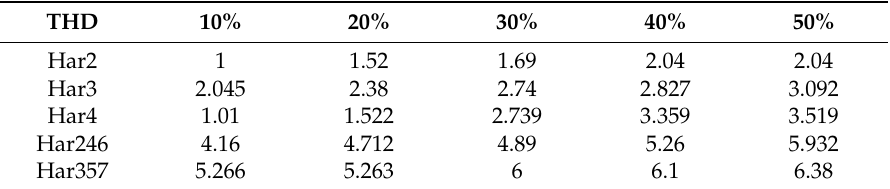
Figure 15. Model measurements of THD. Table 6. The error of calculation THD for Matlab